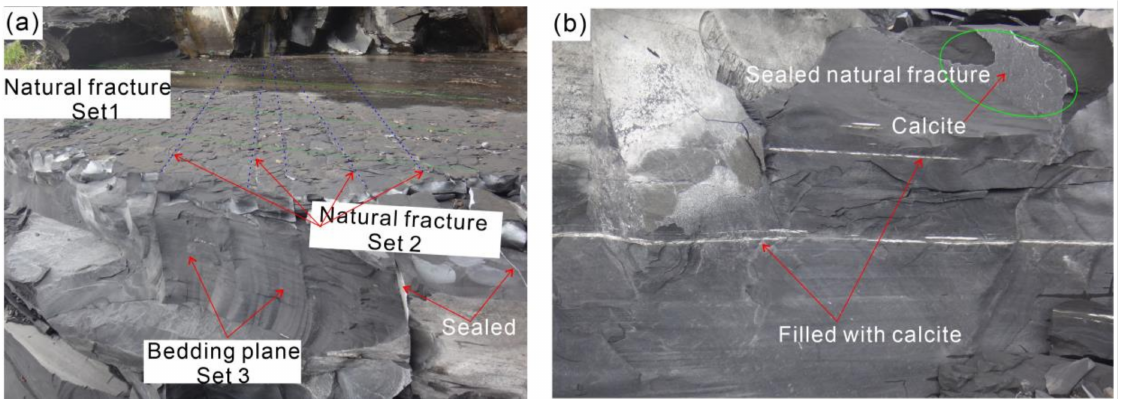
Figure 1. Natural fracture in Longmaxi fresh shale outcrop, China. ( a ) Three groups of NFs can be observed from shale outcrop; ( b ) natural fracture is sealed and filled with